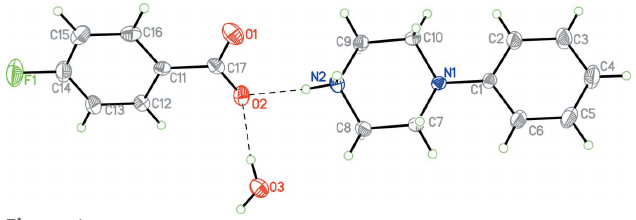
Figure 1 The molecular structure of 1 with hydrogen bonds shown as dashed lines. Atomic displacement parameters are at the 30% probability level.